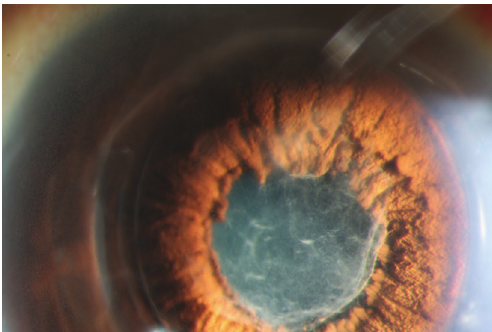
Figure 3: Severe fibrinous reaction one day after foldable toric pIOL implantation in the anterior chamber.